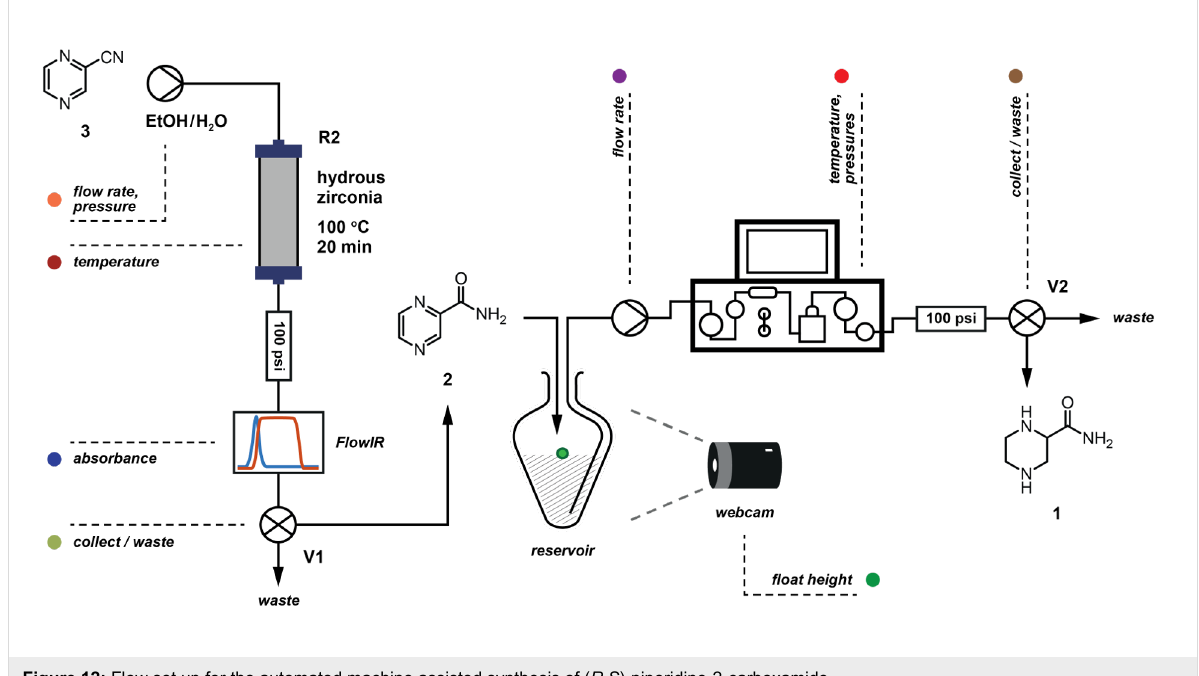
Figure 13: Control sequence for the two-step process.